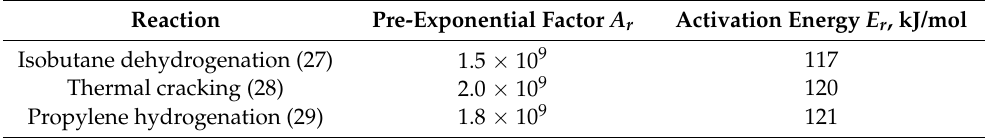
Table 2. Parameters for models of chemical reactions. Reaction Pre-Exponential Factor A r